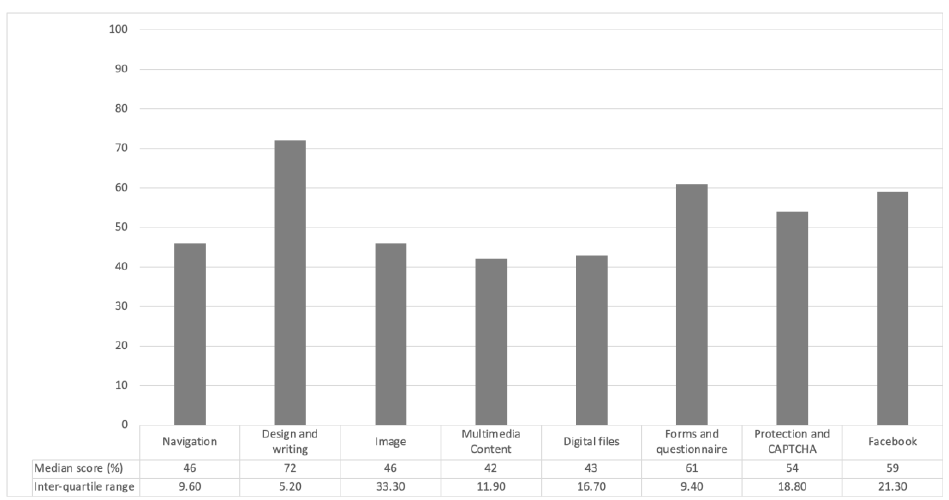
Figure 1. Median score and inter-quartile range per assessment category for the 14 associations.